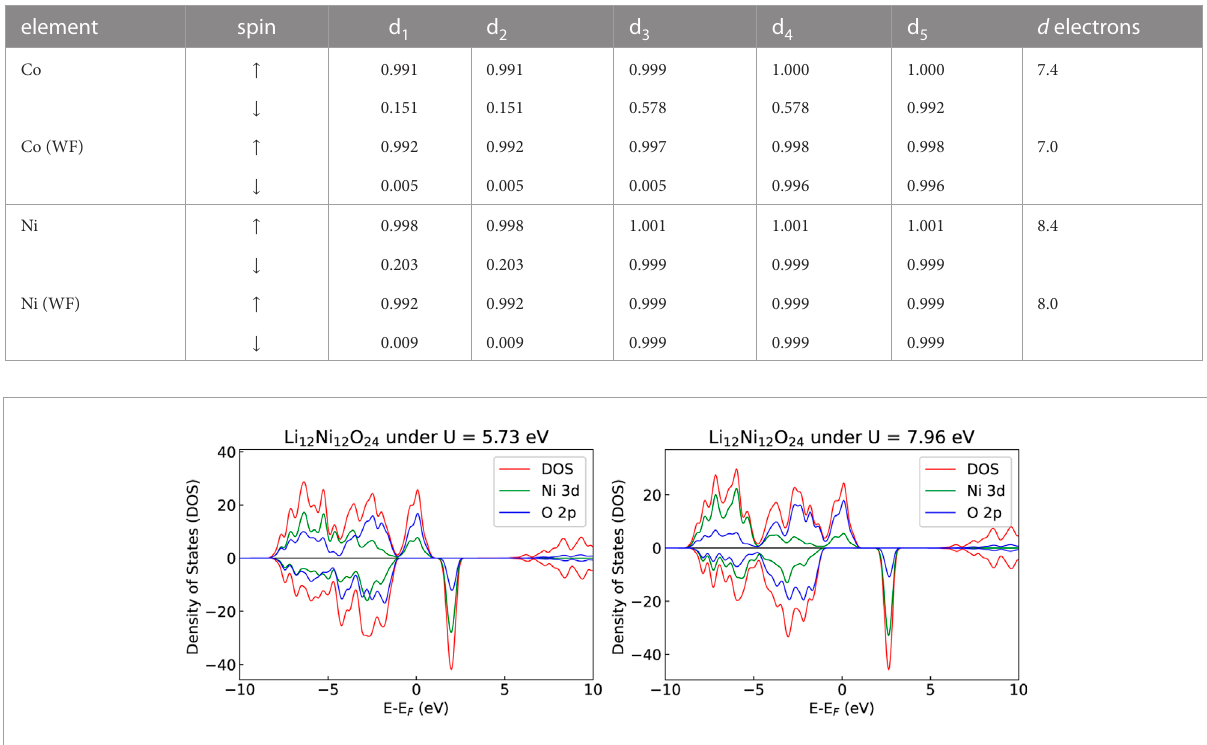
FIGURE 1 The partial and total DOSes computed for LNO with the derived (right) and rescaled (left) Hubbard U